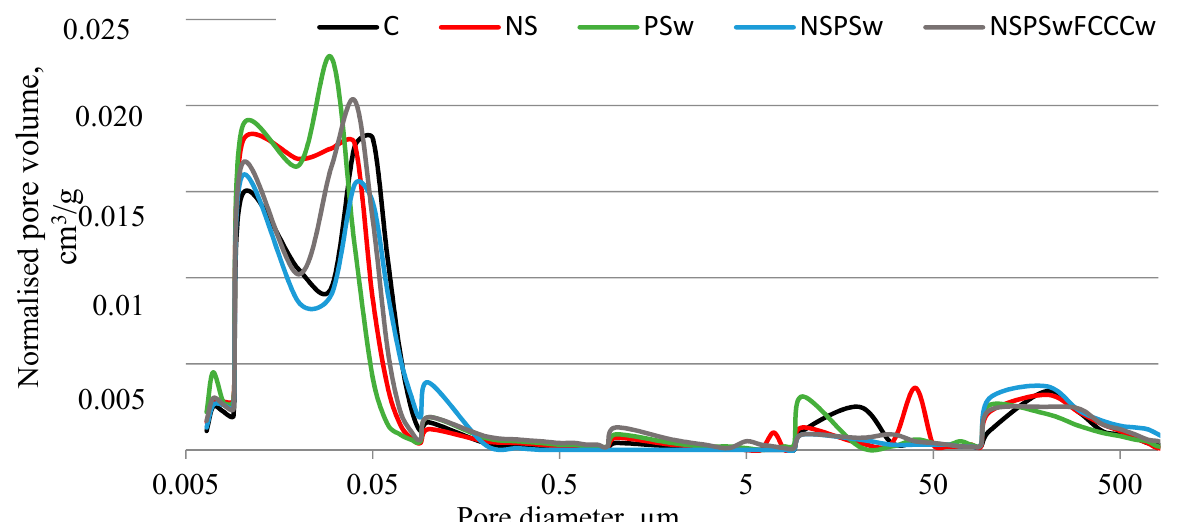
Figure 10. Results of cumulative pore volume in hardened cement paste. Table 3. Mercury intrusion porosimetry (MIP) results in terms of pore diameters (average, me- dian), total surface, accessible and total porosity. Characteristic